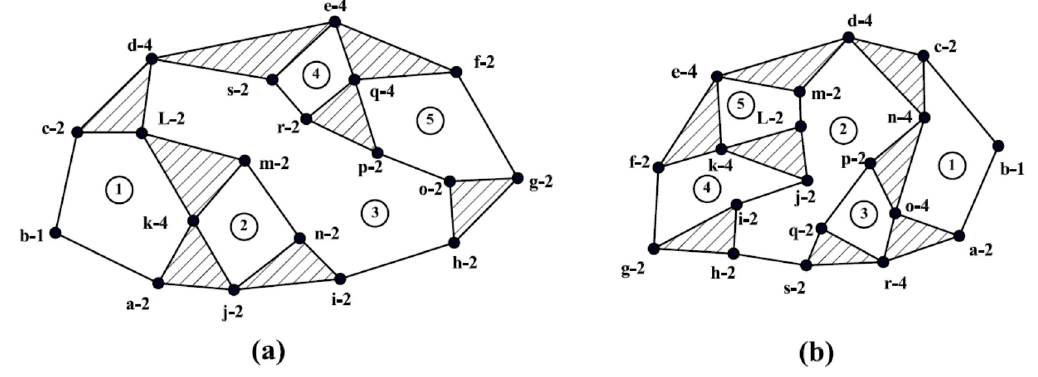
Figure 13. 15-links kinematic chains with simple joints. ( a ) kinematic chain: a. ( b ) kinematic chain: b.